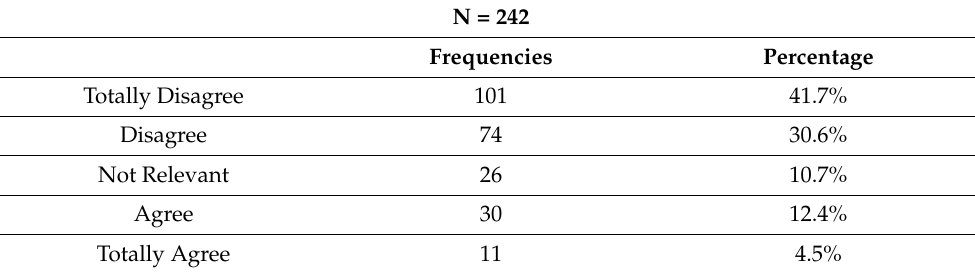
Table 3. Results on concern about climate change.